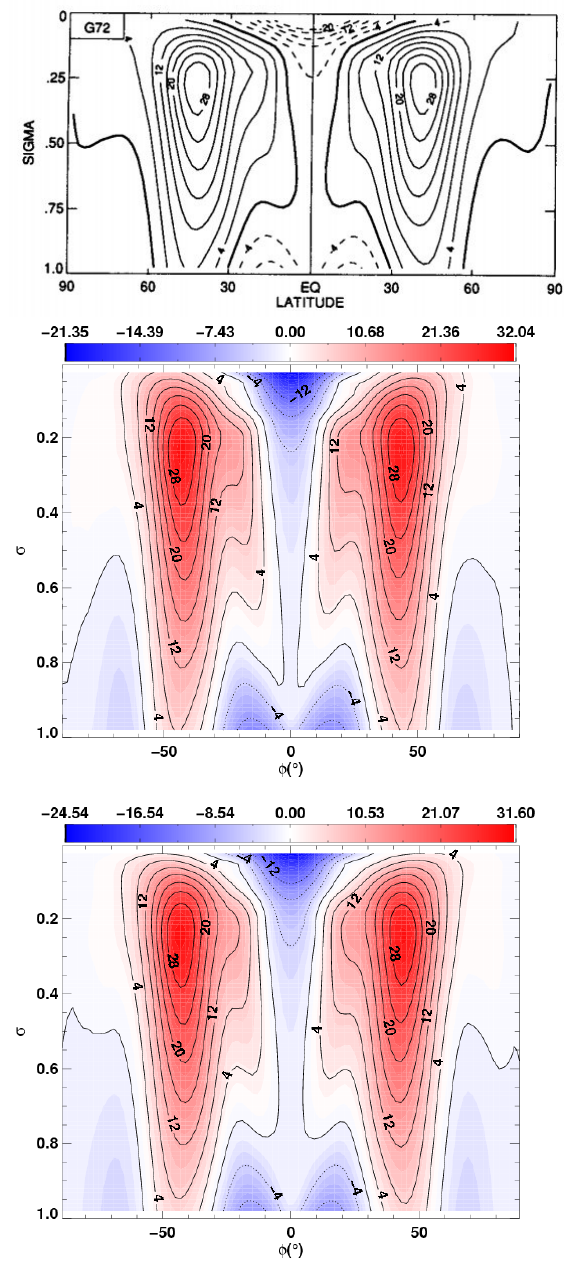
Fig. 5. Figure, for the Held–Suarez test (Held and Suarez, 1994), showing the differences EG − ND of the zonally and temporally av- eraged zonal temperature (K), top panel , and wind (ms − 1 ), bottom panel (see Table 2 for explanation of model types).